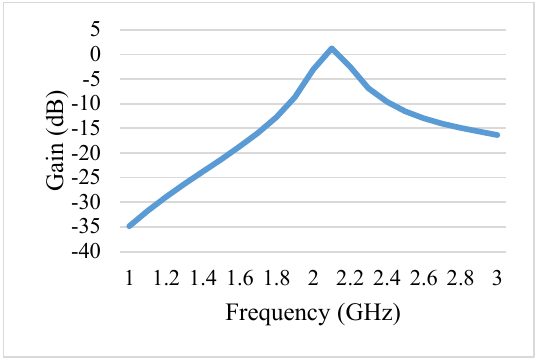
Fig.1.15 Gain vs Frequency relationship of the Antenna 3 Table 1.4 Comparison between three